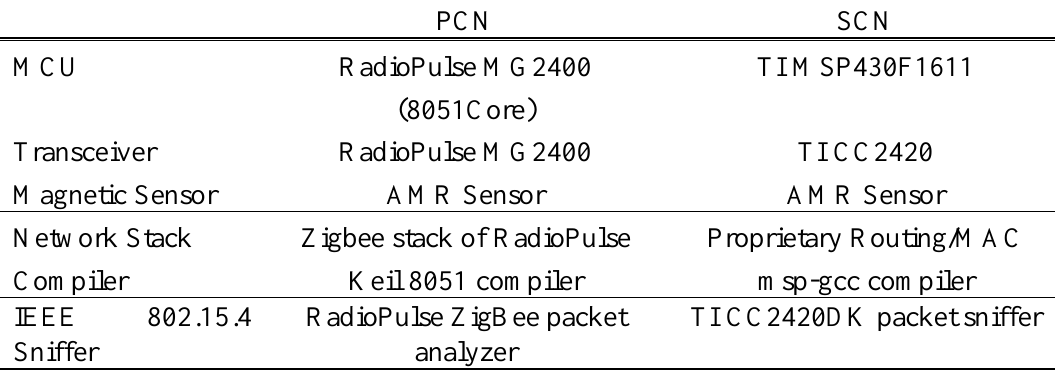
Table 1. Hardware platforms and development environment for